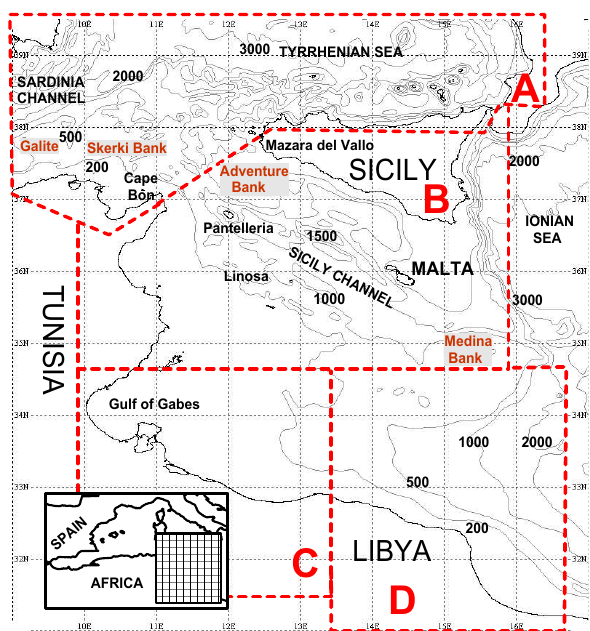
Fig. 1. The Central Mediterranean model bathymetry from US Navy DBDB1 (1/60 ◦ ). The boxes define the sub-domains where diagnostics are calculated: Sardinia Channel and southern Tyrrhenian Sea (box A), Sicily Channel (box B), Tunisian shelf area (box C) and Libyan area (box D).